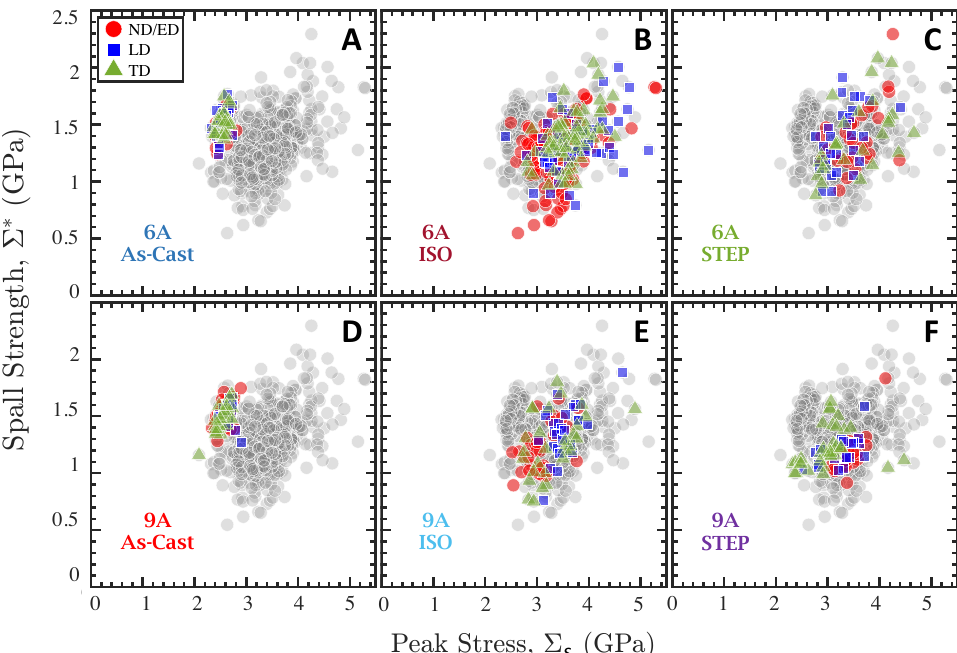
Figure A1. Orientation-based spall strength vs. peak shock stress results for all sample sets. Each frame compares orientation-based results for a specific sample set: ( A ) 6A As-Cast, ( B ) 6A ISO, ( C ) 6A STEP, ( D ) 9A As-Cast, ( E ) 9A ISO, and ( F ) 9A STEP. The full dataset is shown in the background in grey for direct comparison.